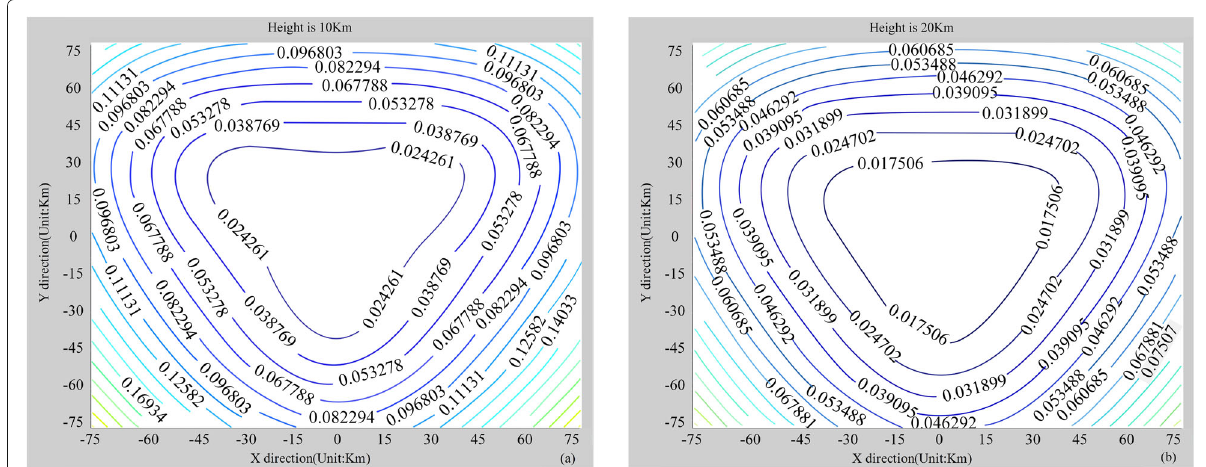
Fig. 4 Influence of different target height on positioning